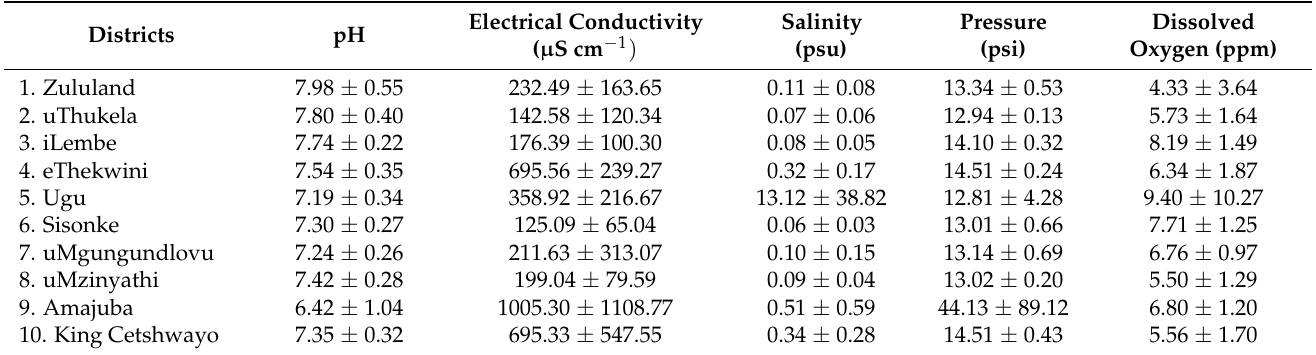
Table 4. Physicochemical parameter values (mean ± SD) of water measured in 11 districts in KZN